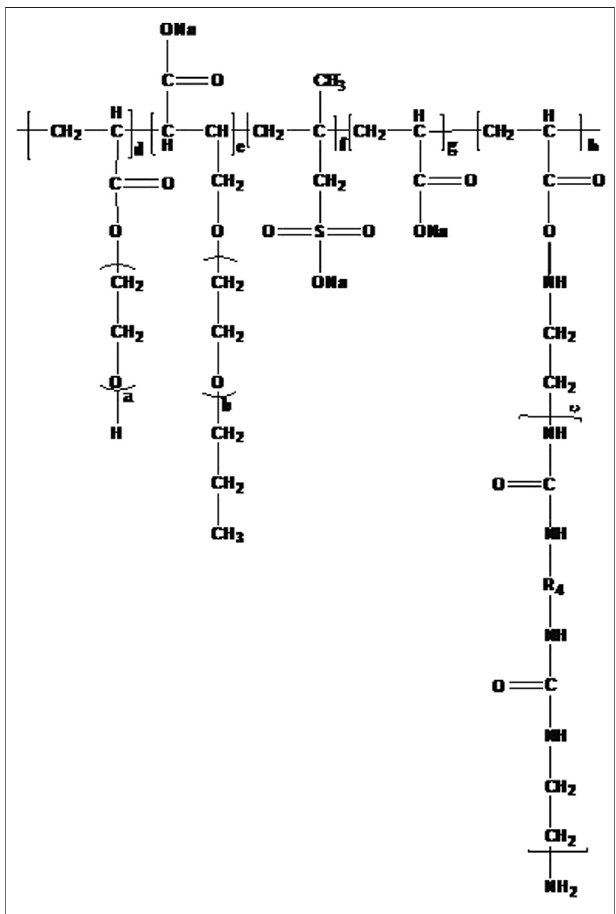
FIGURE3| Structure ofsynthesizedmodi fi edpolycarboxylate(M-PCE).